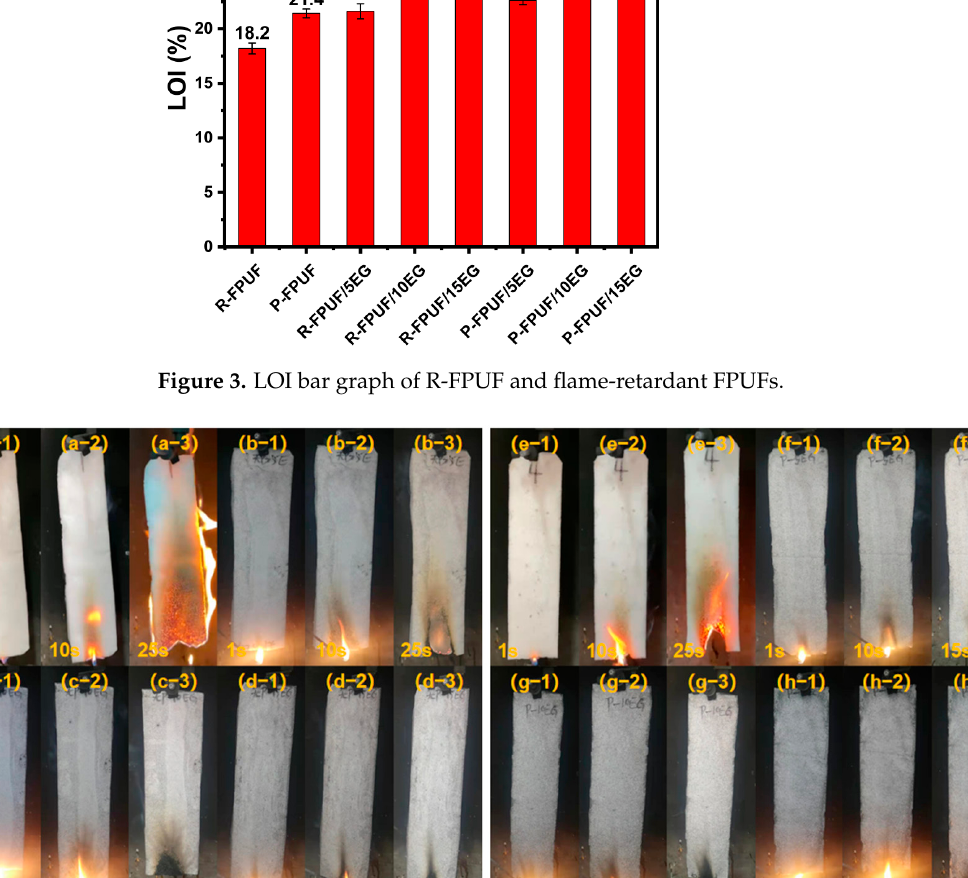
Figure 3. LOI bar graph of R-FPUF and flame-retardant FPUFs.